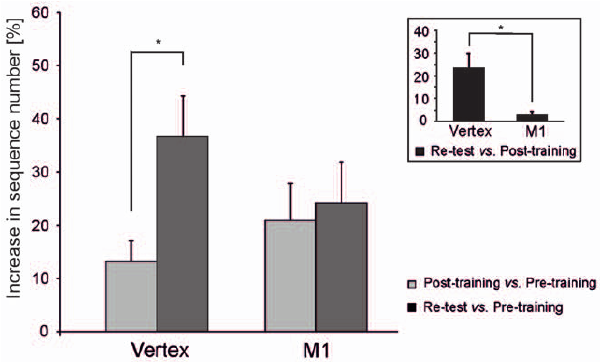
Figure 5. Lack of early boost following M1 cTBS. The increase in the total number of sequences in the post-training and re-test sessions is expressed in percent with respect to data gathered in the pre-training session. This shows that, whereas the performance in the Vertex and M1 groups was comparable in the post-training session, no early boost was found in the M1 group. This difference between groups was confirmed by data shown in the inset (same conventions as in Fig. 4). Error bars indicate one